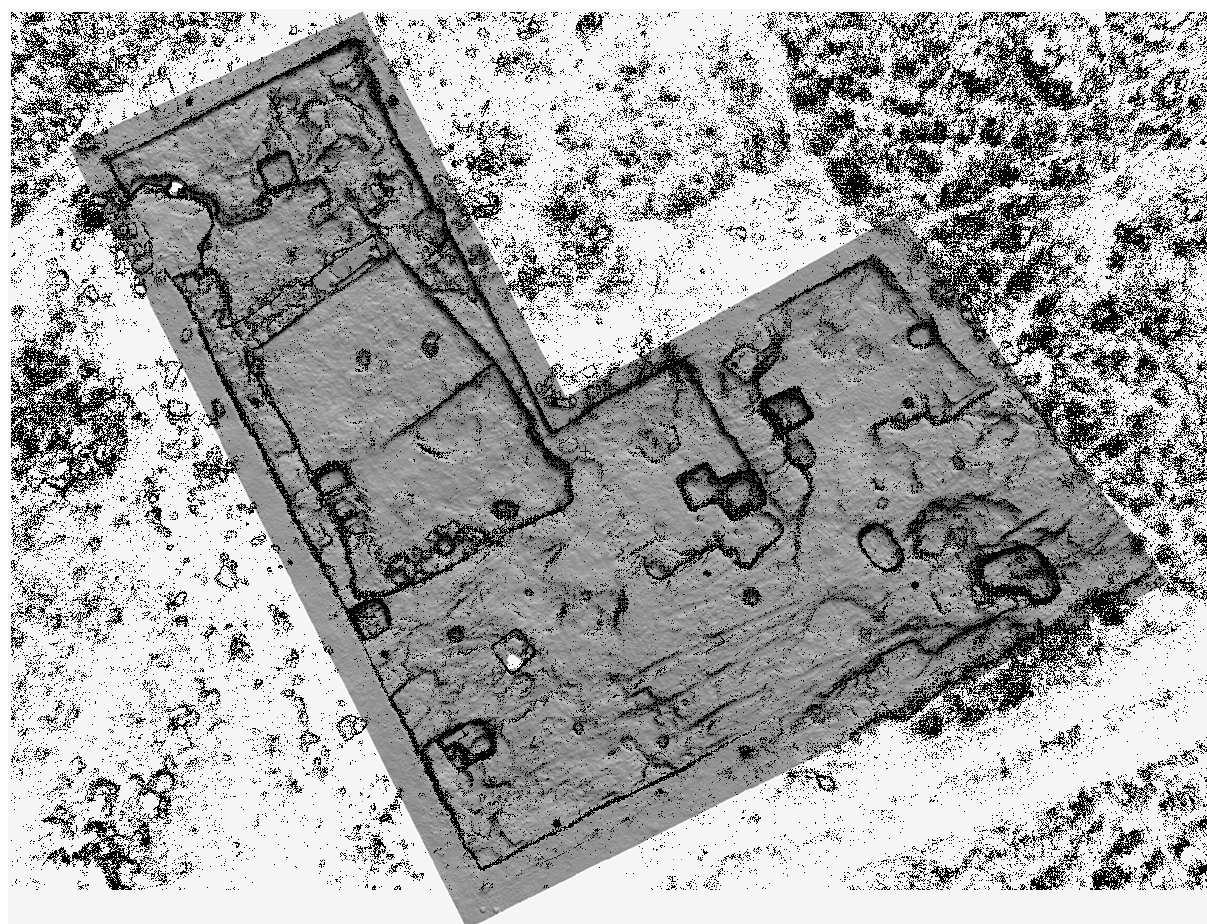
Figure 4. The same plan as a superimposition of the point cloud on a shaded